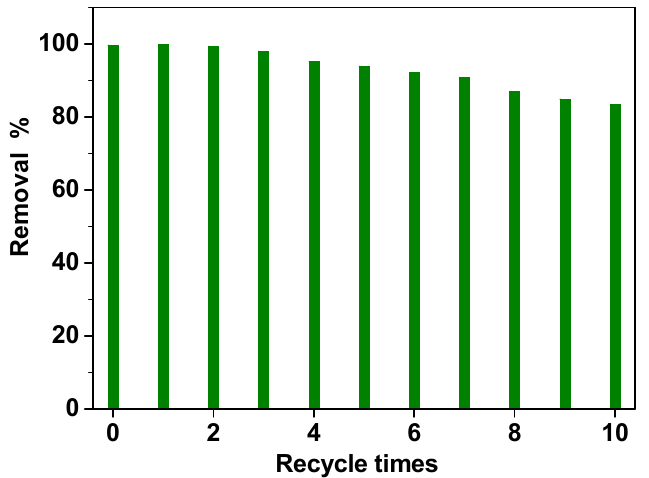
Figure 11. Reusability of the PVDF HFP_RuO 2 60 electrode: COD evolution during 10 times treat- ment.